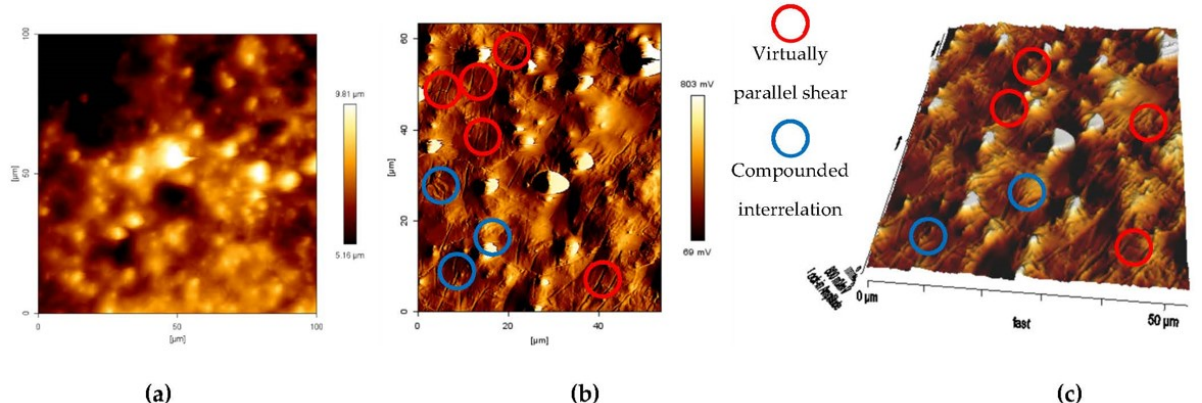
Figure 5. AFM topographic images of the shear band deformation in the MRE matrix ( a ) initial state of tapping-mode topographic image, ( b ) parallel and compounded interrelation shear bands, and ( c ) Three-dimensional topographic image of the shear band